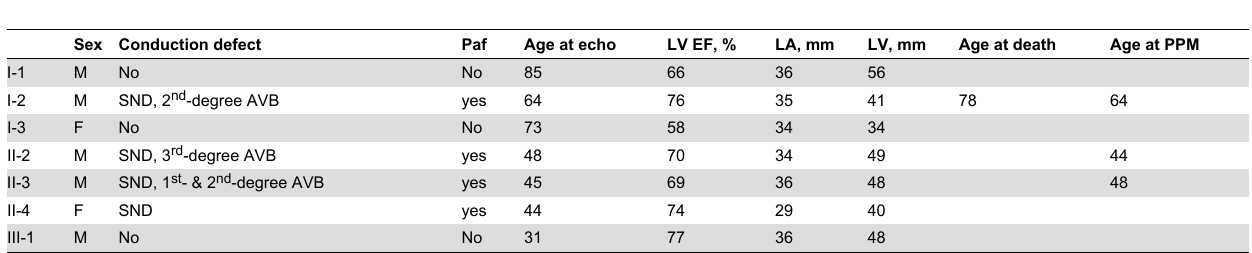
Table 1. Demographic and phenotypic information on the study